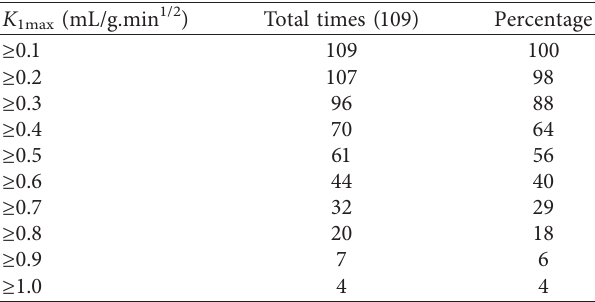
Table 9: Distribution of percentages of prediction index K during the test.